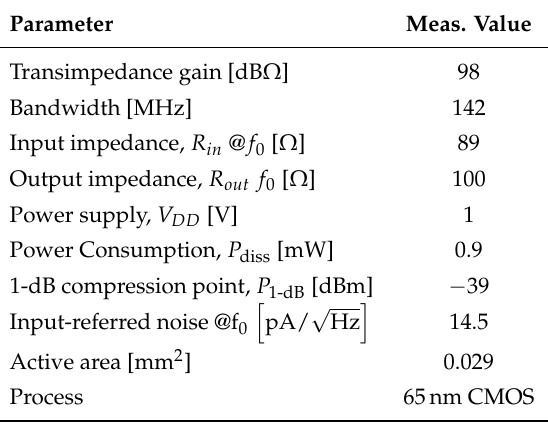
Table 1. Performance parameters of the proposed TIA.